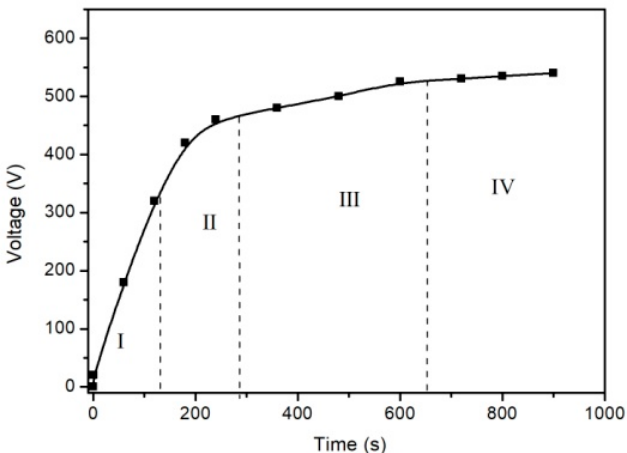
Figure 1. Voltage–time response of the PEO Figure 1. Voltage – time response of the PEO process.